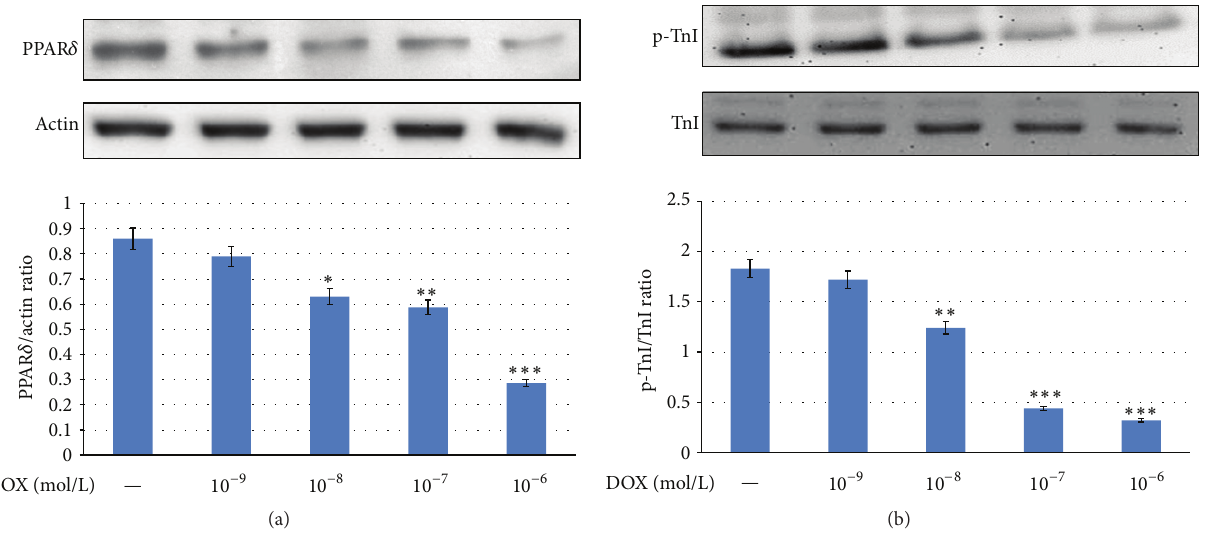
Figure 3: Effects of doxorubicin on PPAR 𝛿 expression and cardiac troponin I phosphorylation in neonatal rat cardiomyocytes. Cardiomyocytes from neonatal rats were cultured with 10 −9 ∼ 10 −6 mol/L doxorubicin for 24 h. These cells were harvested to determine the expression of PPAR 𝛿 (a) and the level of troponin I phosphorylation (b) using Western blotting analysis. All values are presented as mean ±